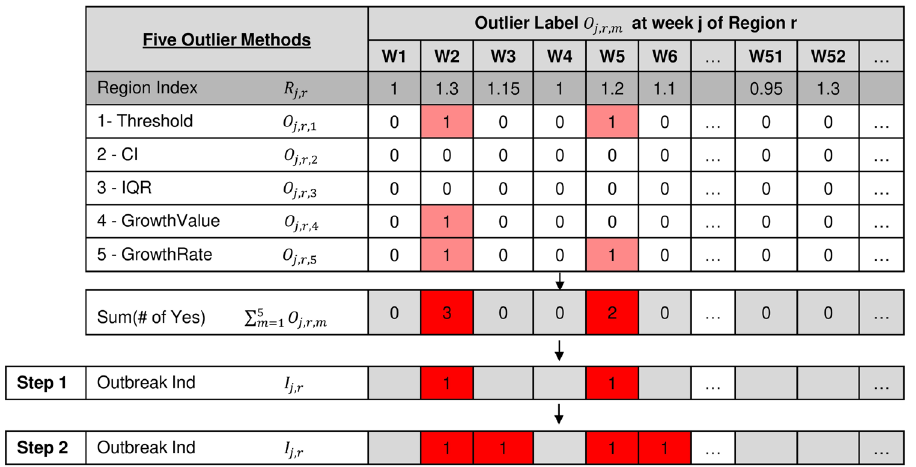
Figure 5. Influenza outbreak detection for historical data illustration.